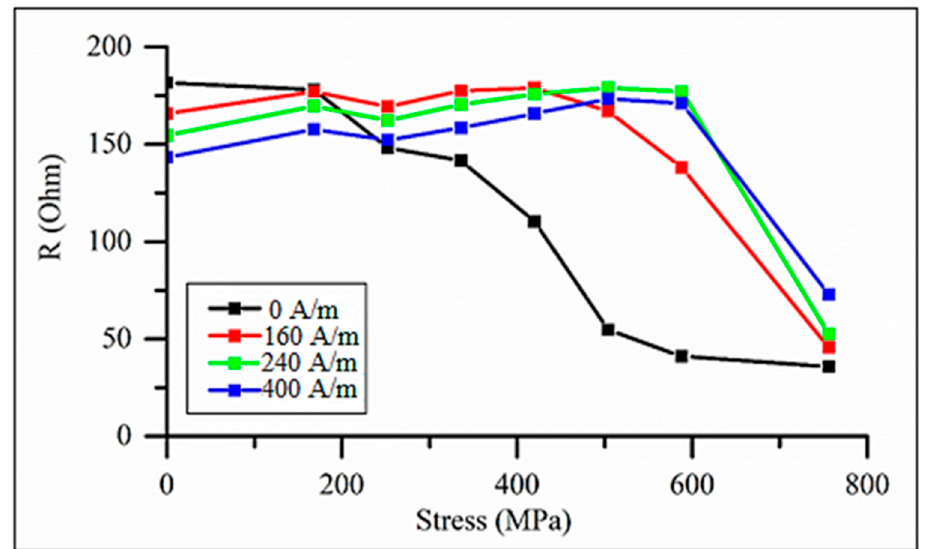
Figure 17. Real part of impedance vs. tensile stress for as-prepared amorphous Co 71 Fe 5 B 11 Si 10 Cr 3 microwires with an external field as a parameter. Frequency is 50 MHz.